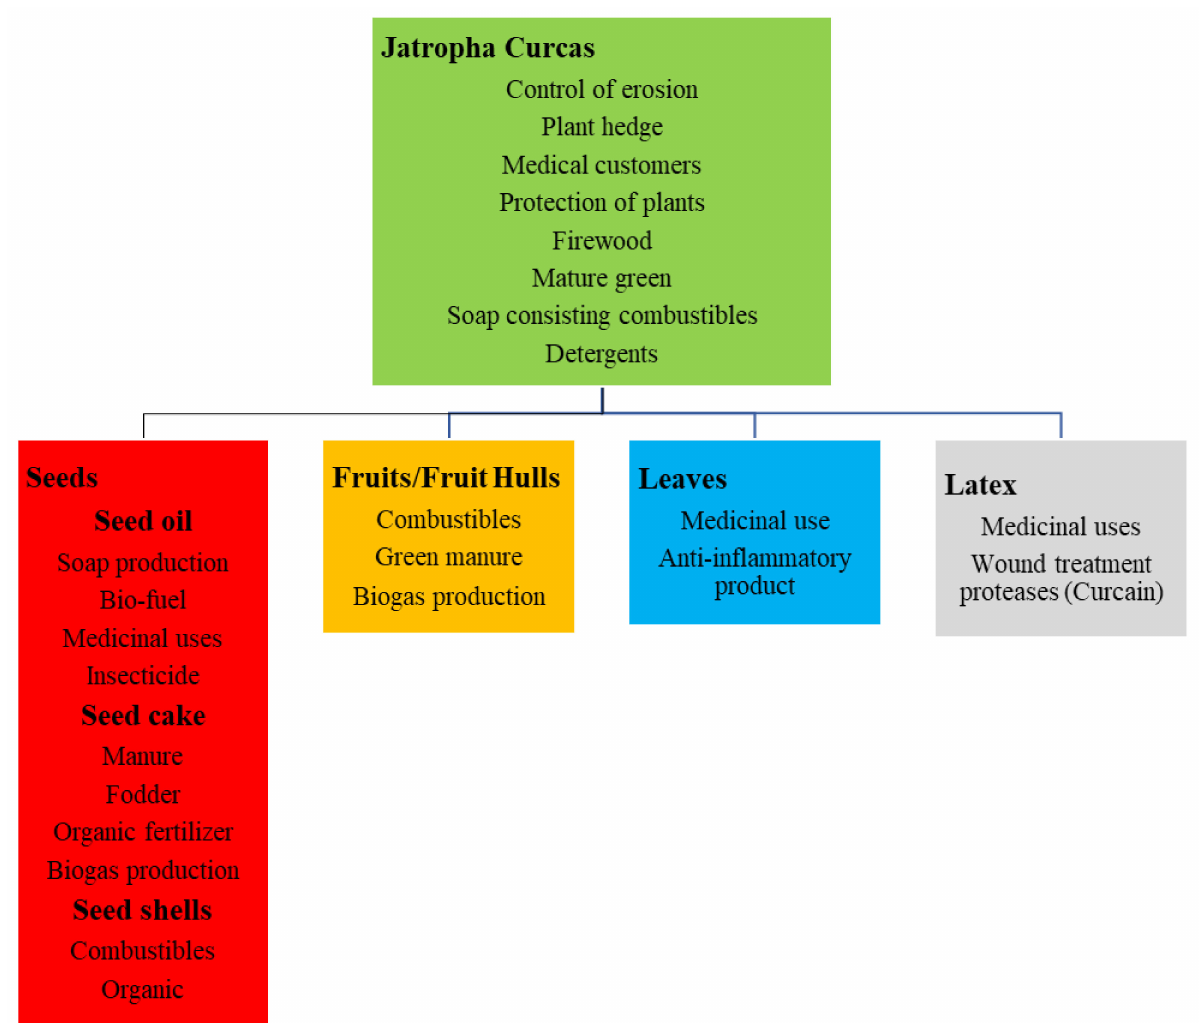
Figure 10. A few essential Jatropha Curcas usages